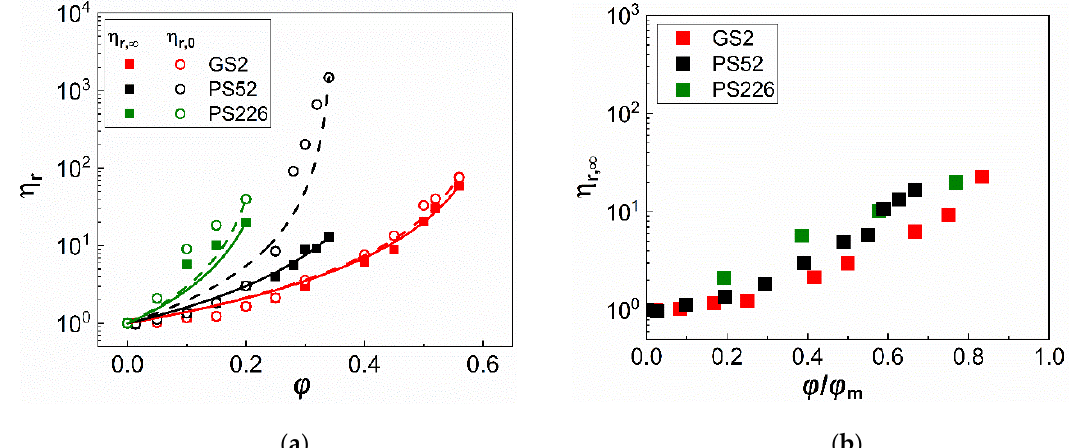
Figure 3. ( a ) Zero shear rate ( η r ,0 ) and infinite shear rate ( η r , ∞ ) relative viscosities of the three types of particle suspensions as a function of particle volume fraction ( ϕ ). The continuous and dashed lines correspond to the Quemada fittings to the experimental data (Equation (4)); ( b ) Infinite shear rate ( η r , ∞ ) relative viscosity values of all suspensions as a function of the particle volume fraction ( ϕ ) normalised with ϕ m , ∞ .